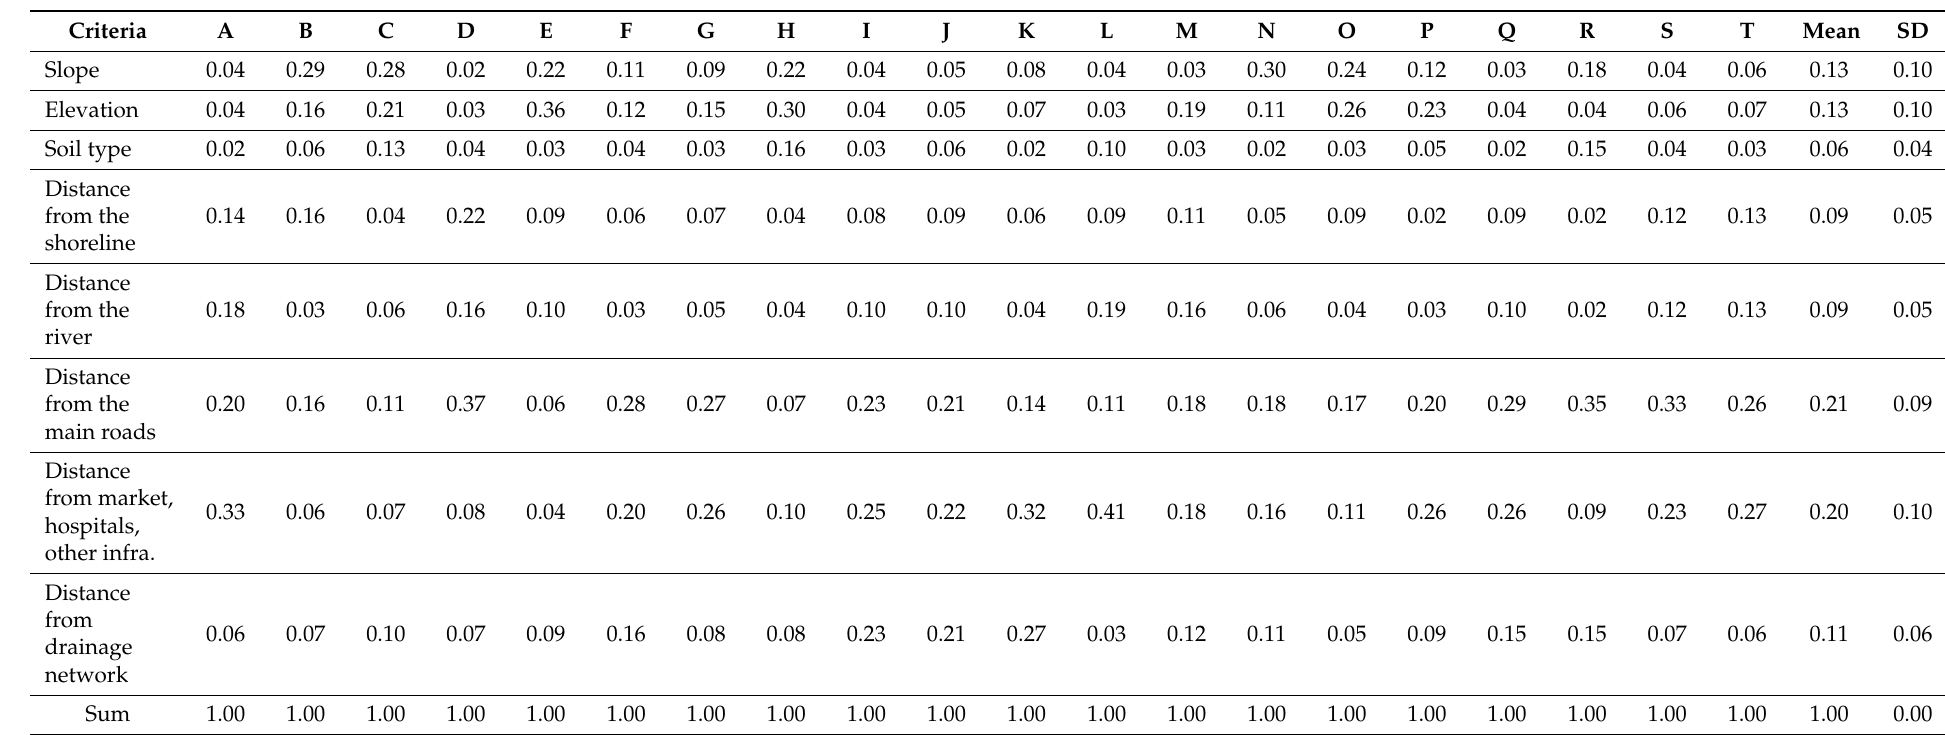
Table 3. Weights of the criteria for residential areas suitability mapping using Analytic Hierarchy Process